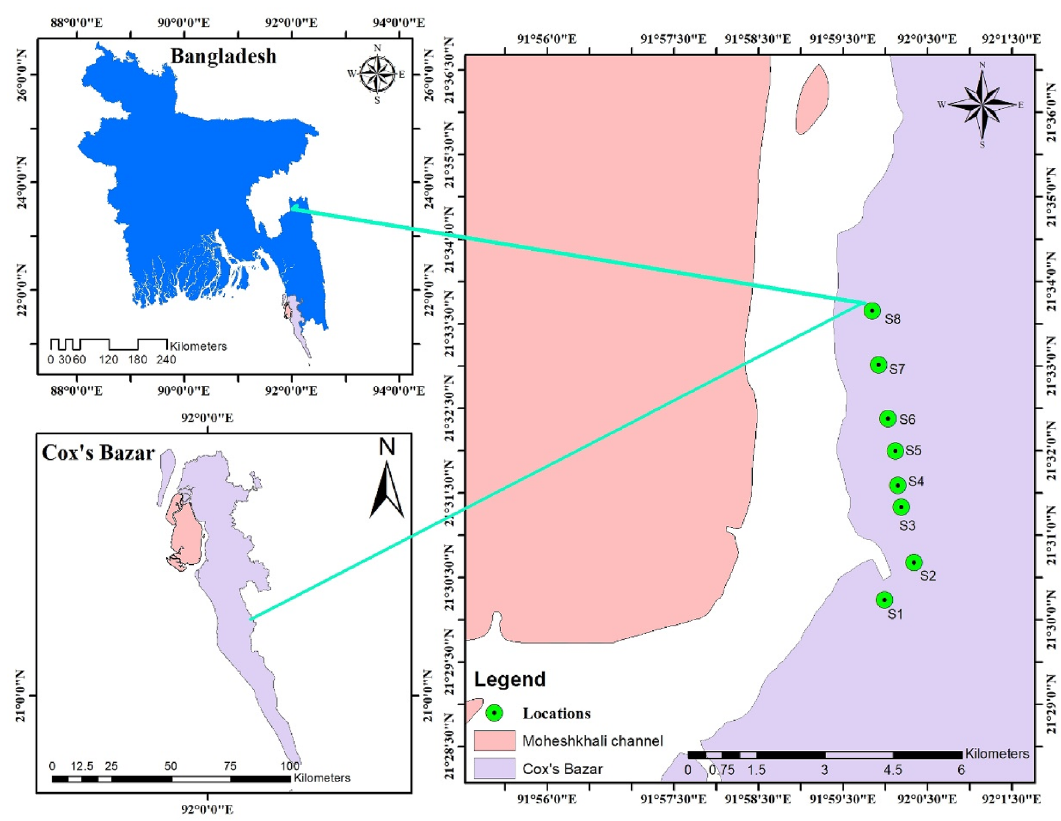
Figure 1. The geographic location of the sampling points along the Maheshkhali Channel coast. This map was constructed using ArcGIS